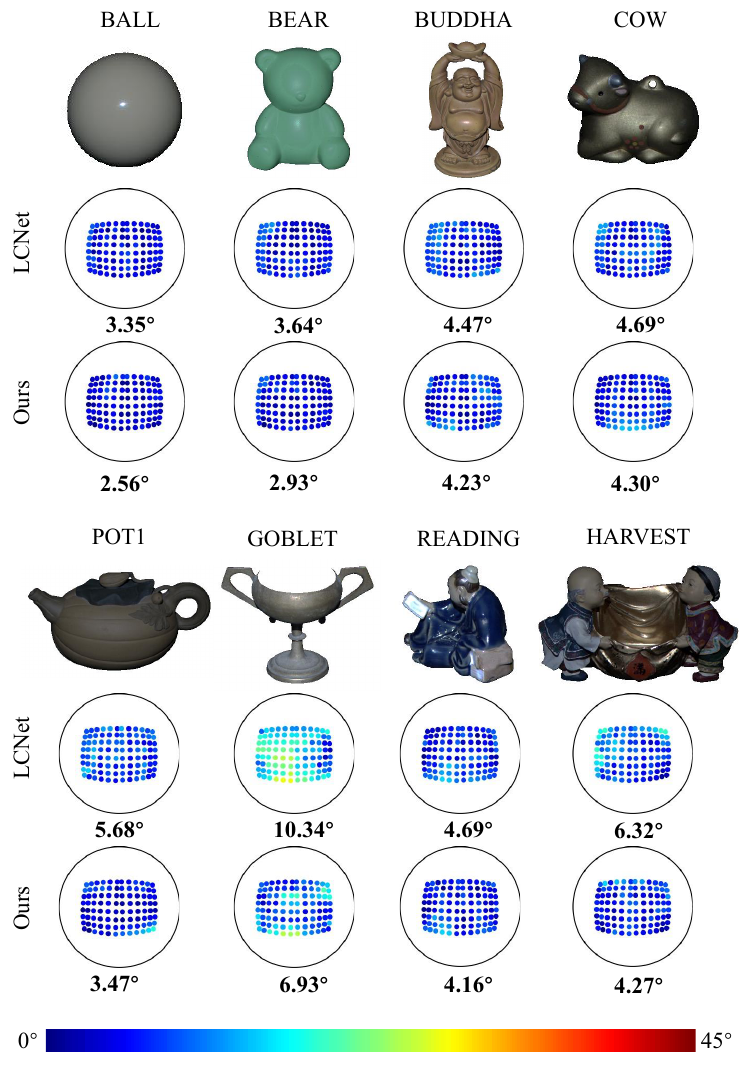
Figure 8. Quantitative light direction evaluation results on the DiLiGenT benchmark dataset. Rows 1 and 4: Captured images of eight samples in the DiLiGenT benchmark dataset. Rows 2–3 and 5–6: Light direction error distributions of corresponding samples for LCNet and ReDDLE-Net, respectively. Following [17], we mapped the light source [ x , y , z ] to a point [ x , y ] . The color of the points corresponds to the magnitude of the